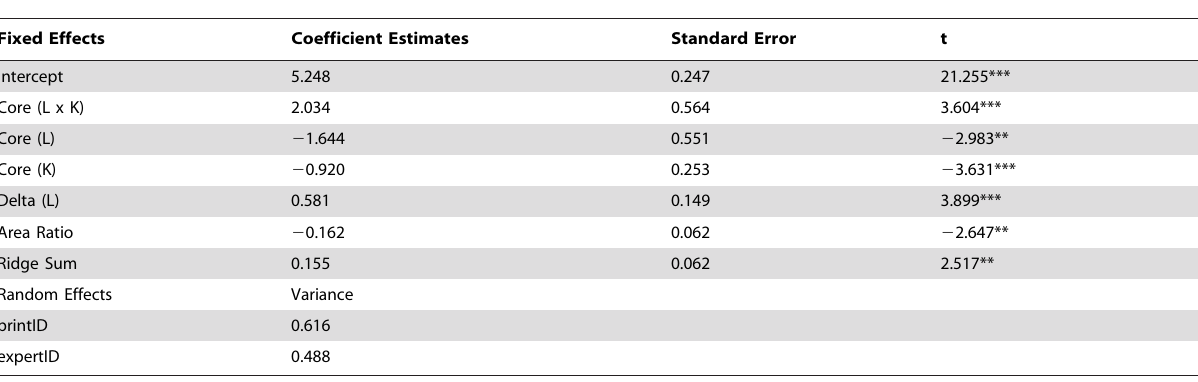
Table 5. Predictors for confidence rating